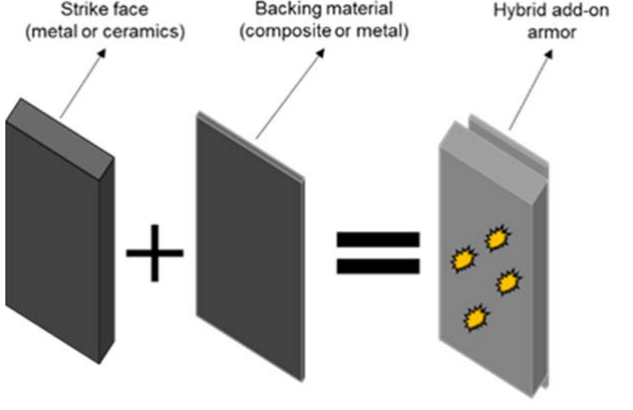
Figure 3. Armor design